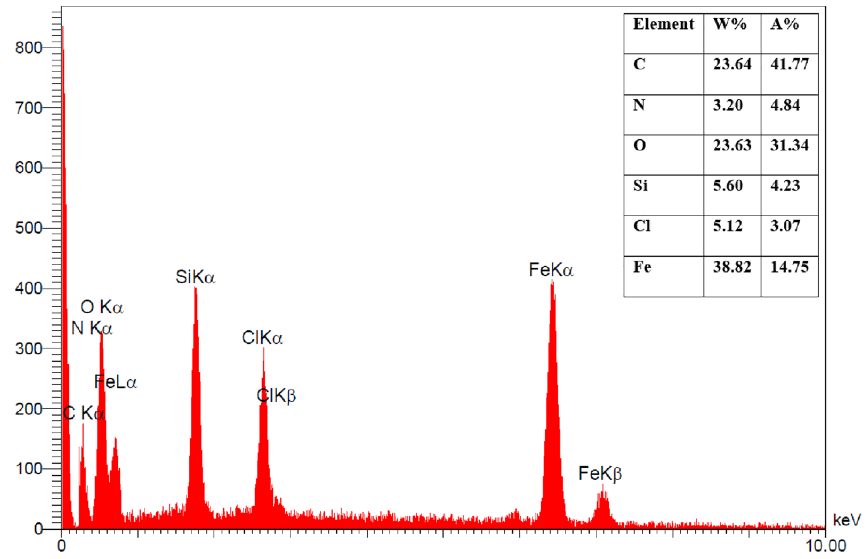
Figure 9. EDAX analysis of Pip@MGO nanocomposite.